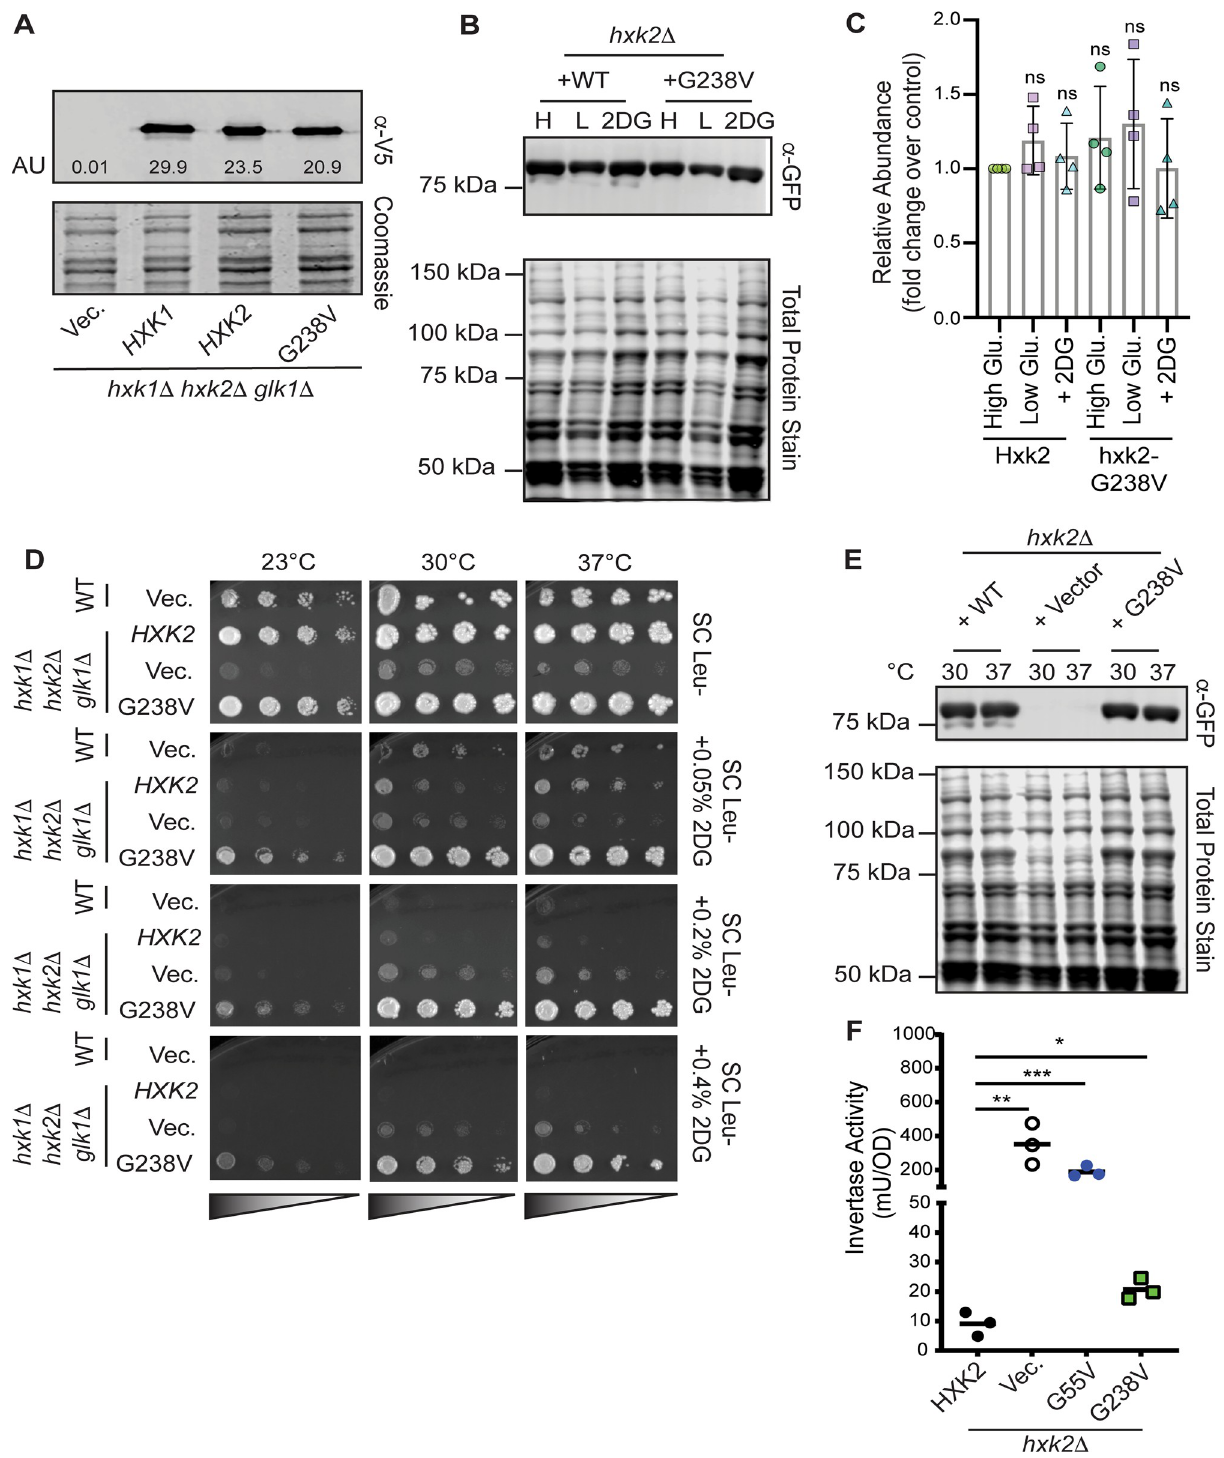
Fig 4. Hxk2 G238V is a stable protein that allows for growth on glucose in cells that otherwise lack hexokinase activity. (A) Western blot of V5-epitope-tagged HXK1 , HXK2 , and hxk2 G238V expressed in hxk1 Δ hxk2 Δ glk1 Δ cells. Quantification of the Hxk2 western signal is depicted in arbitrary units (AU) on the blot. (B) Western blot showing GFP-tagged Hxk2 protein levels from whole-cell extracts prepared from hxk2 Δ cells grown in synthetic complete media with 2% glucose (H for high glucose) or 0.05% glucose (L for low glucose) alone, or with 2% glucose and the addition of 0.2% 2DG for two hours (2DG for medium containing this drug). REVERT total protein stain was used as a protein loading control. (C) Quantification of